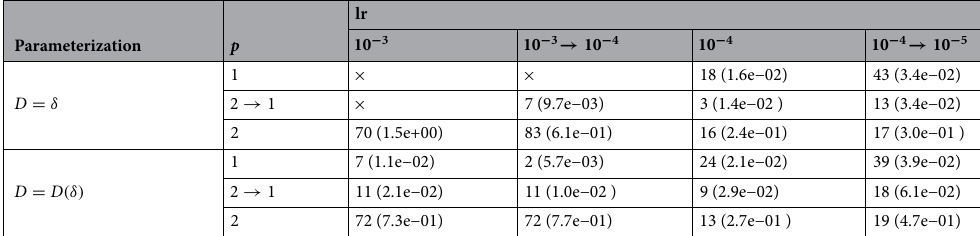
Table 1. Rel. error | D − D 0 | / D 0 in % in the diffusion coefficient and PDE residual norm after training (in brackets) for different optimization strategies averaged over 4 trainings on synthetic data with noise. It can be seen that the accuracy correlates with the PDE residual after training, i.e. the lower the PDE residual,